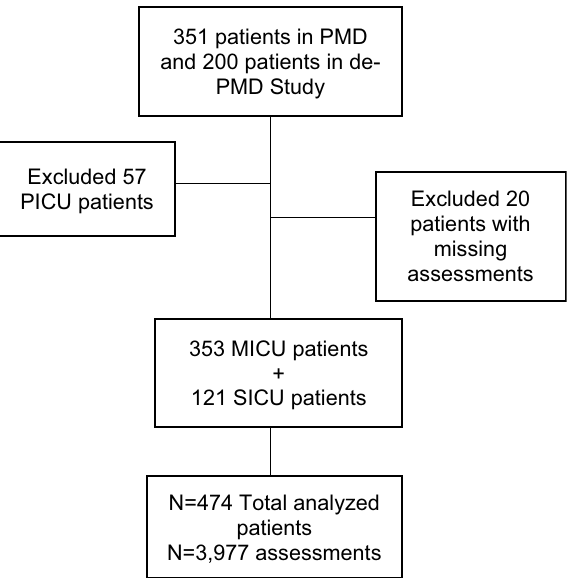
Figure 1. Study participants. PICU, Progressive Intermediate Care Unit; PMD, pharmacological management of delirium; de-PMD, de-prescribing in the pharmacological management of